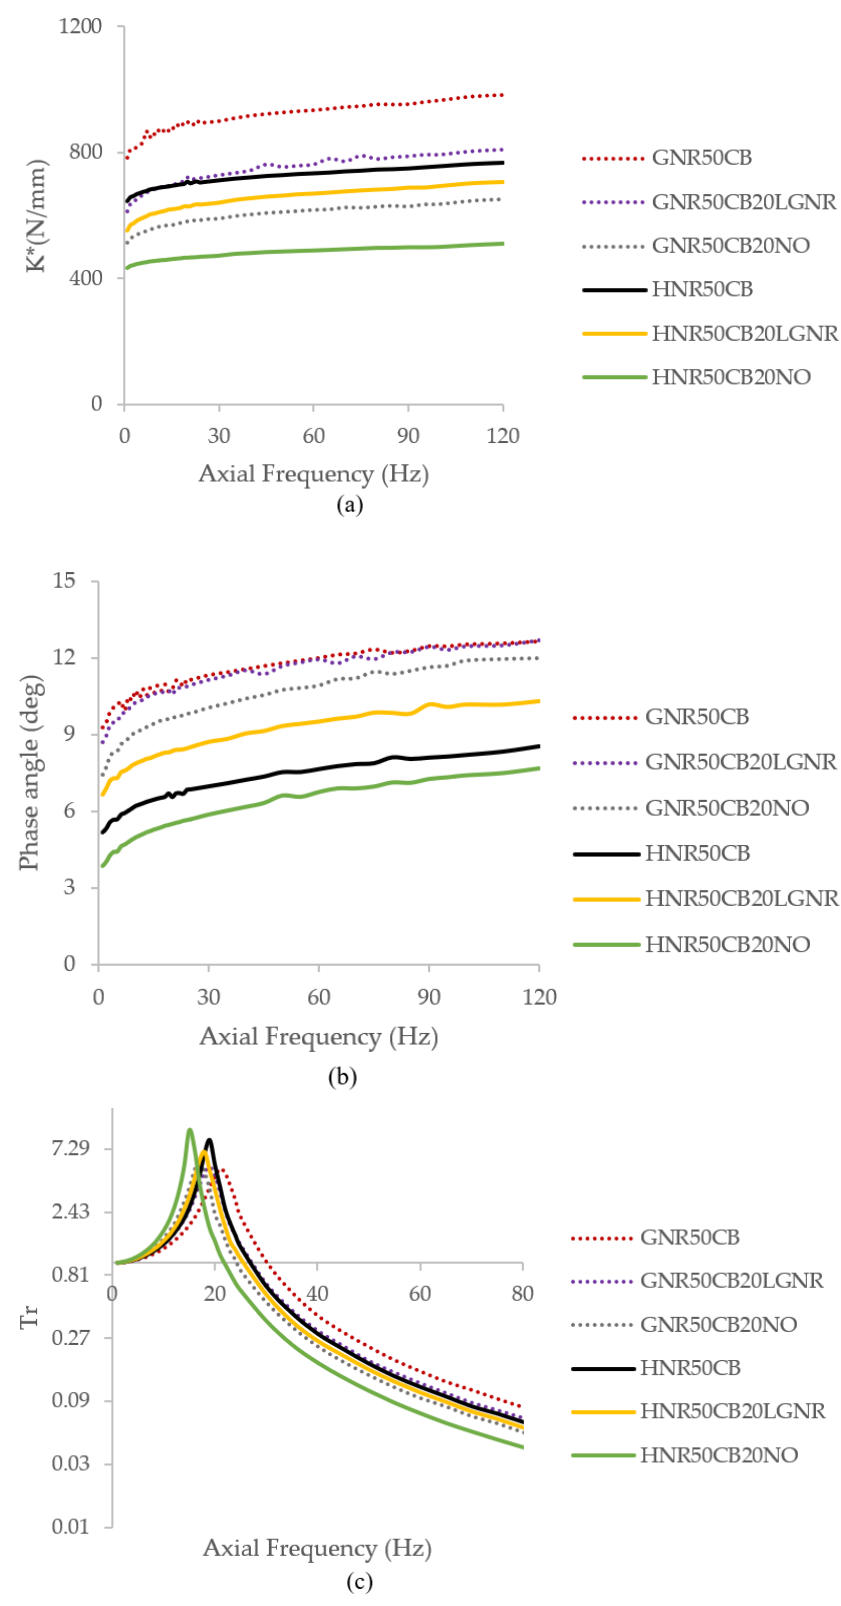
Figure 13. ( a ) Dynamic stiffness represented by the complex stiffness (K*); ( b ) phase angle; and ( c ) transmissibility of natural rubber composites at 0.01mm peak-to-peak amplitude.